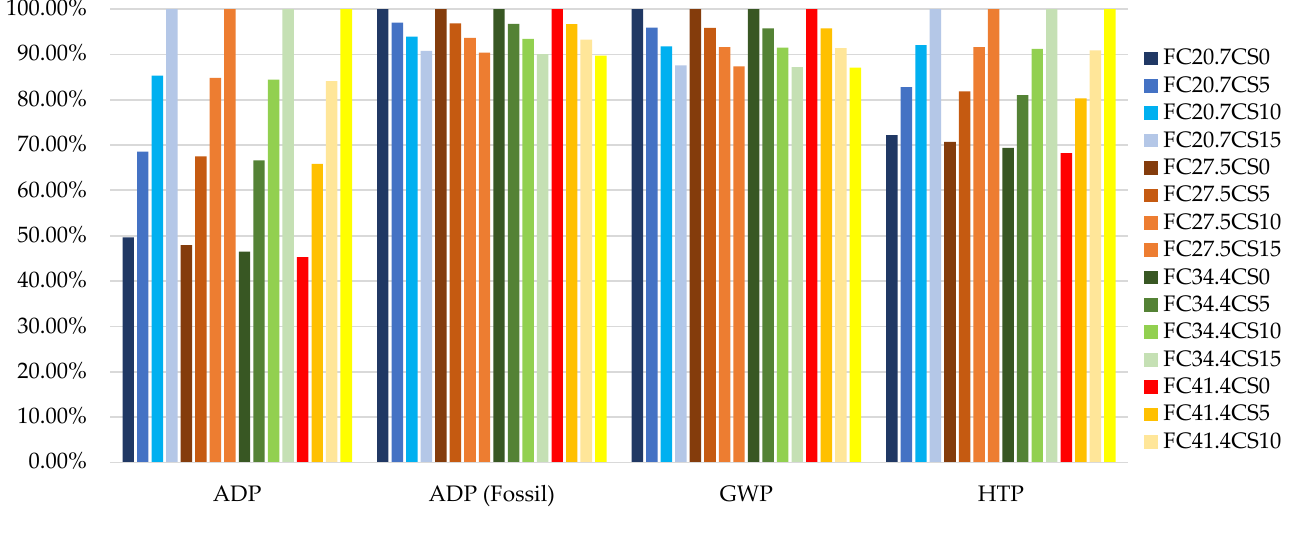
Figure 7. Three-story building environmental impact assessment.